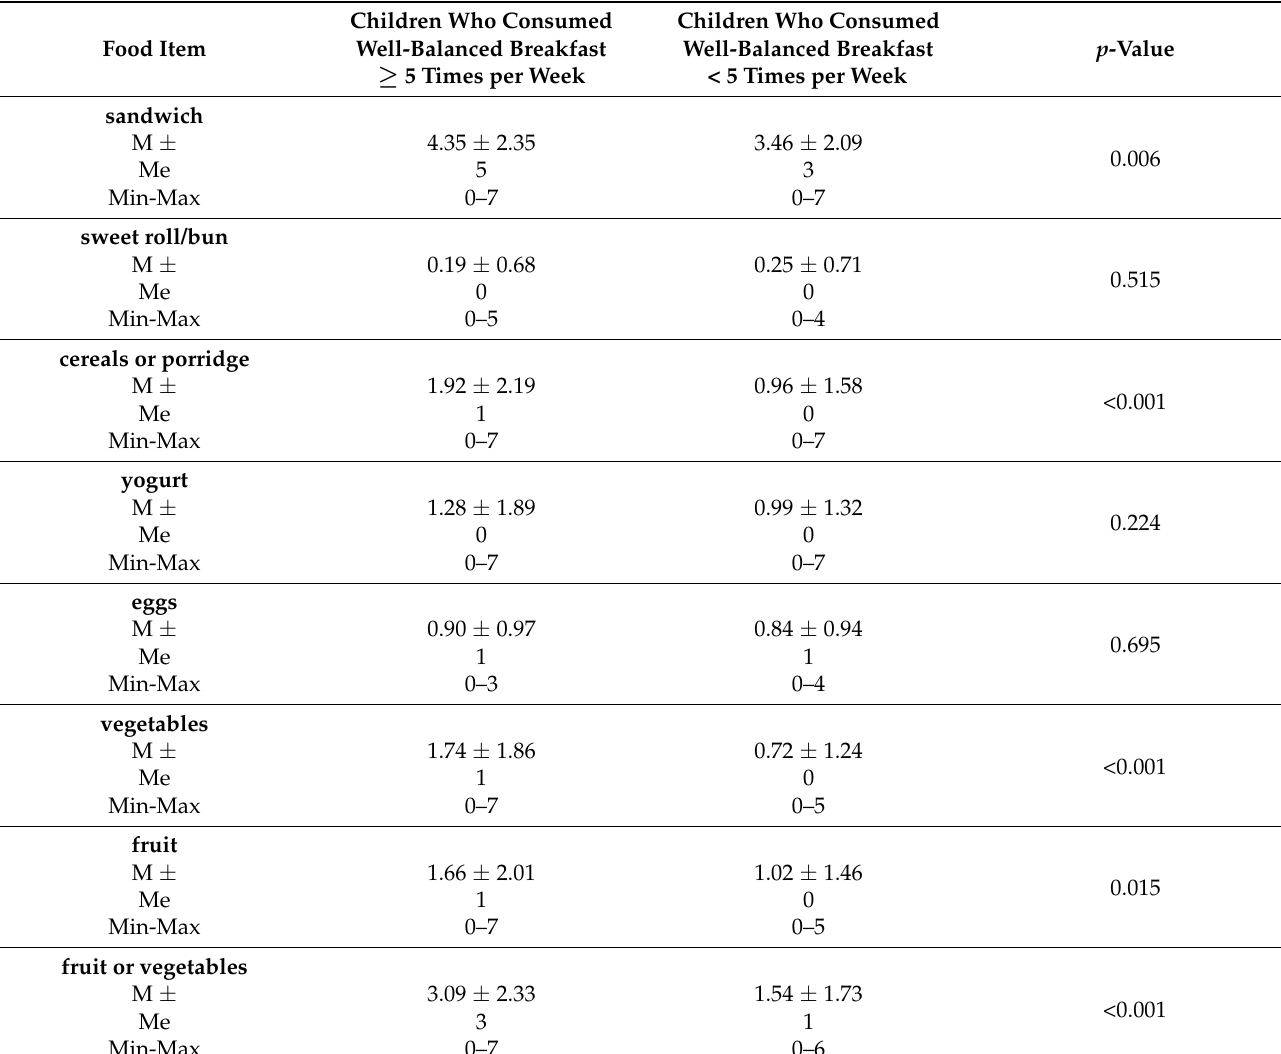
Table 5. Consumption frequency of selected food items for breakfast during the week in group of children who consumed well-balanced breakfast 5 or more days per week or less than 5 days per week.